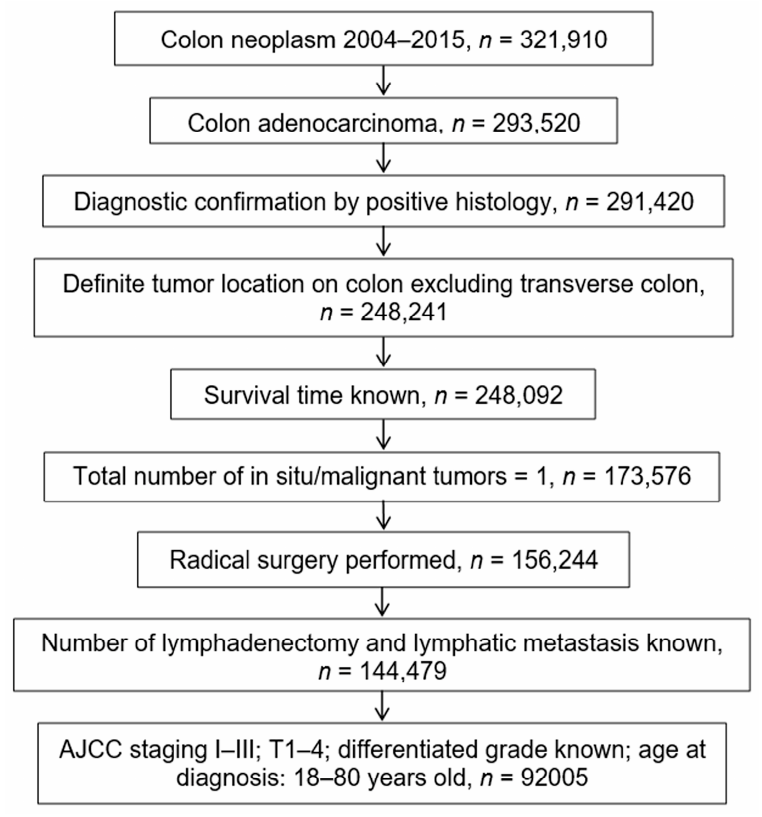
Figure 2. Screening flowchart for colon cancer in the SEER database. Footnotes: AJCC , American Joint Committee on Cancer; T , primary tumor; SEER , the Surveillance, Epidemiology, and End Re- sults.